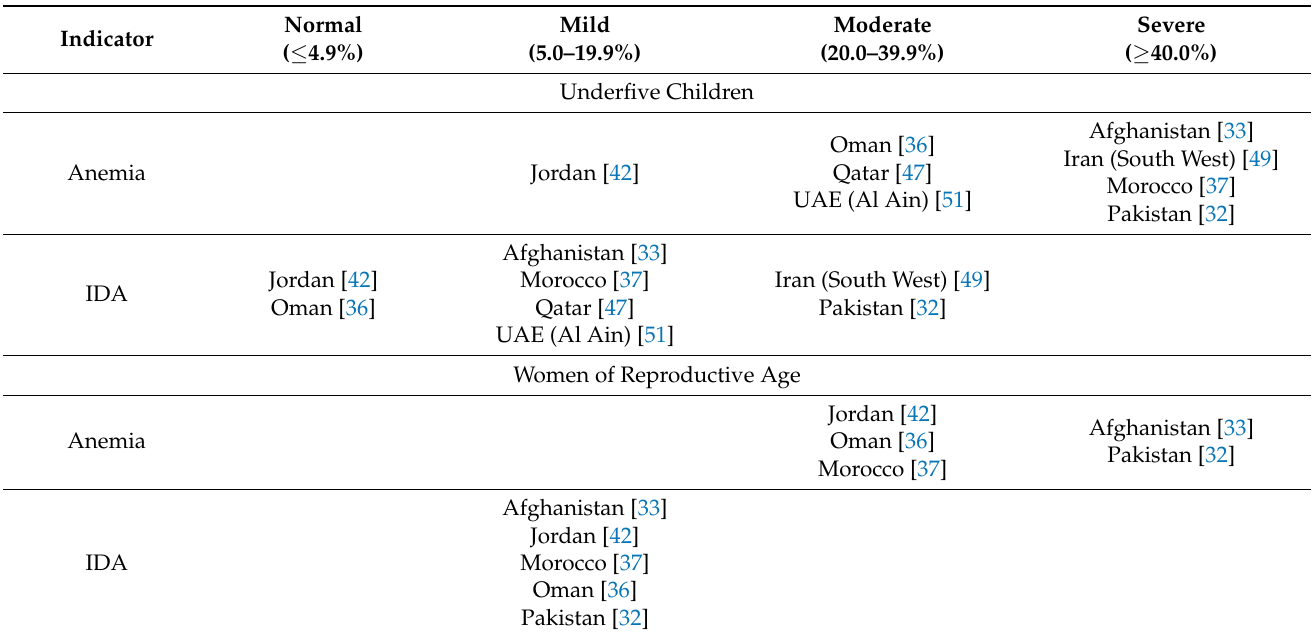
Table 2. Comparison of the public health significance of the burden of anemia vs. IDA based on studies that have reported on